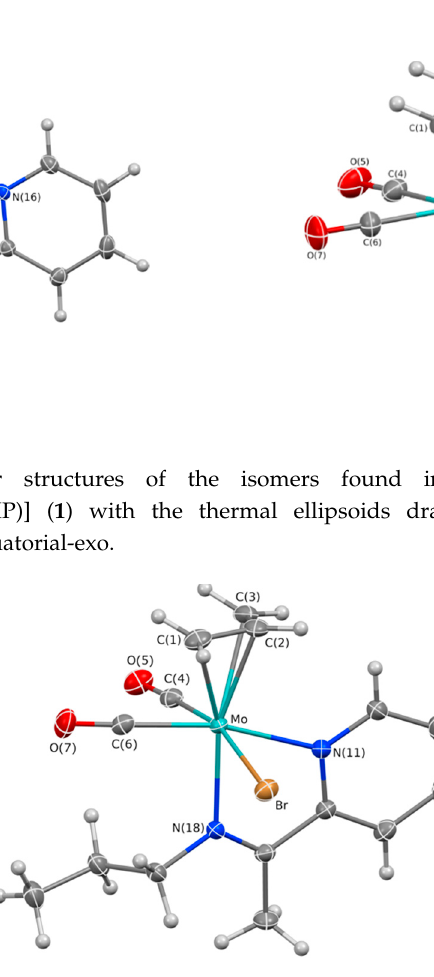
Figure 2. View of the asymmetric unit of [Mo( η 3 -C 3 H 5 )Br(CO) 2 (Me-IMP)] ( 2 ) showing the exo-axial binding arrangement adopted and thermal ellipsoids drawn at the 50% probability level.